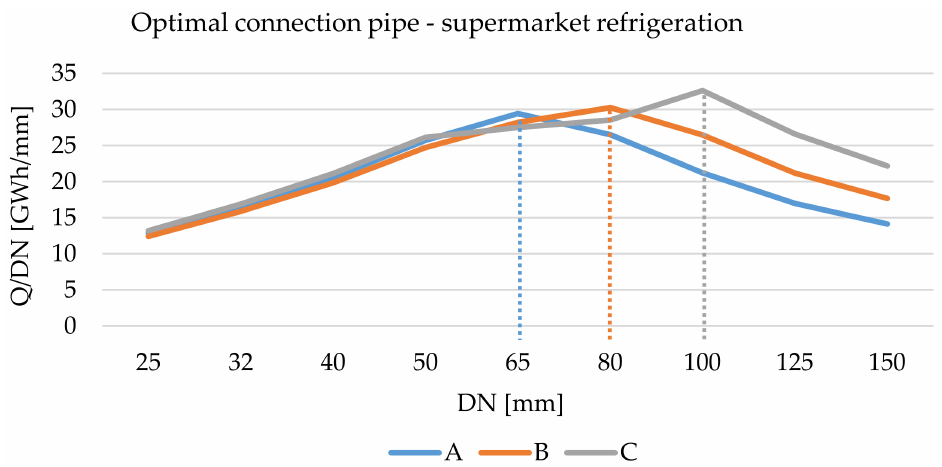
Figure 14. Optimal DH network connection pipe for supermarket refrigeration waste heat utilization concerning different DH network temperature regimes.